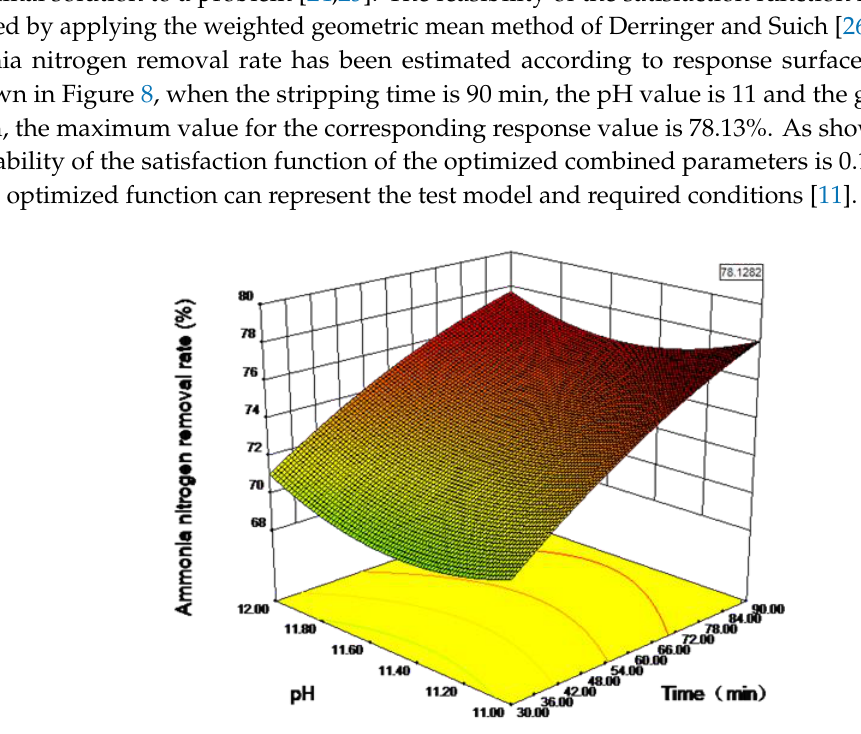
Figure 8. Response surface plot of the predicted value of ammonia nitrogen removal rate with different pH values and stripping time.